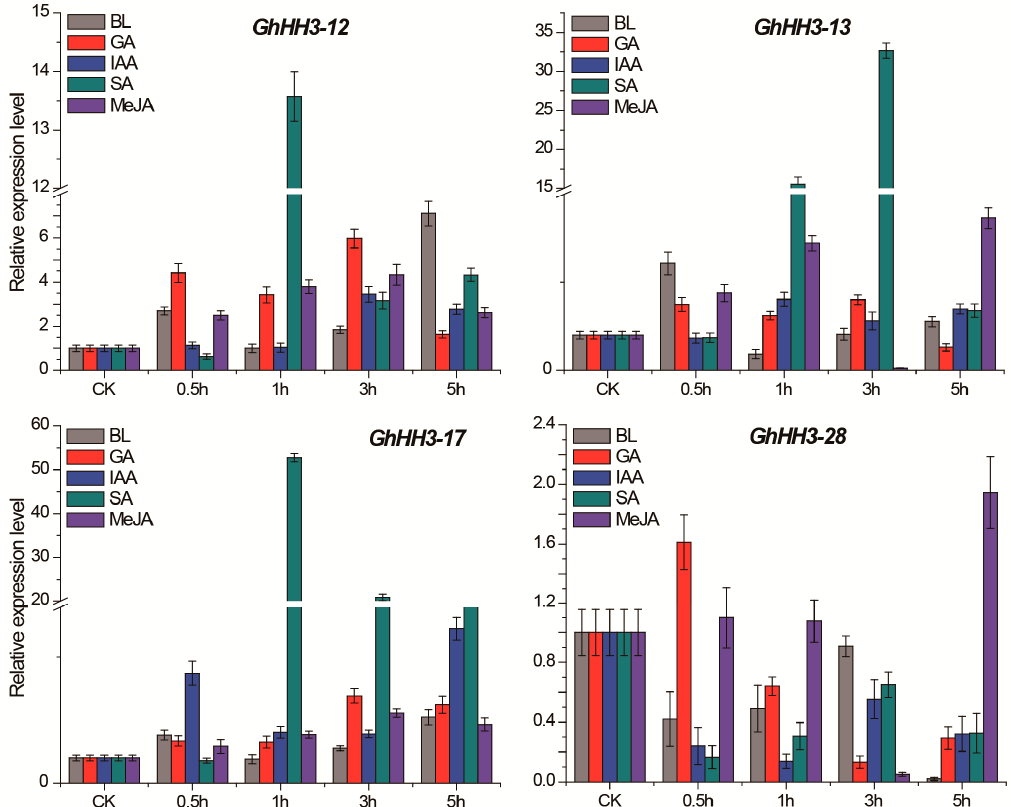
Figure 6. Expression analysis of selected GhHH3 genes in cotton seedlings under exposure to five different phytohormonal stress stimuli including brassinolide (BL), gibberellic acid (GA), indole-3-acetic acid (IAA), salicylic acid (SA), and methyl jasmonate (MeJA). Error bars indicated standard deviations (SD) among three independent biological experiments.